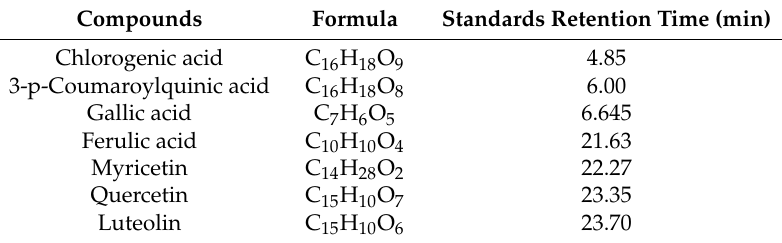
Figure 1. HPLC-DAD chromatogram of hydroethanolic extract of Ammodaucus leucotrichus Cosson and Durieu. (1) Chlorogenic acid, (2) 3-p-coumaroylquinic acid, (3) gallic acid, (4) ferulic acid, (5) myricetin, (6) quercetin, (7) luteolin. Table 1. DHEAM revealed compounds and their retention